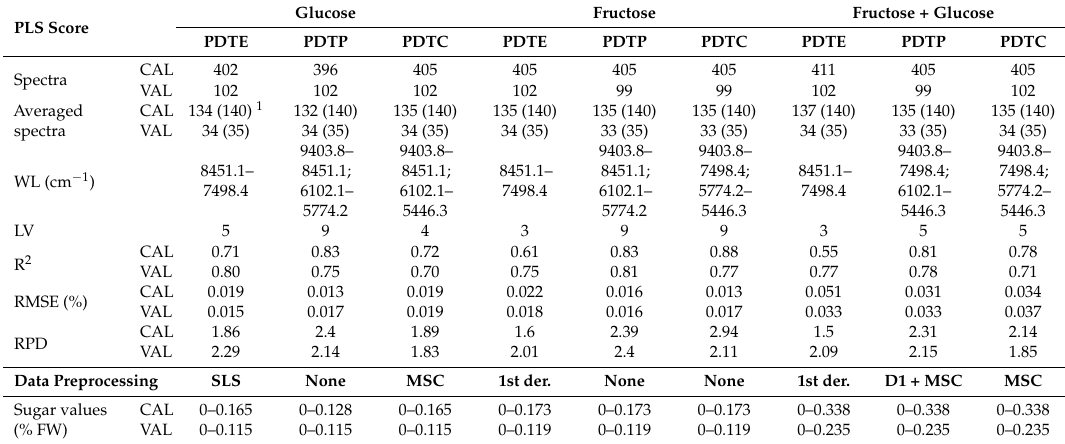
Table 4. PLS values of sugar content prediction of the potato variety Markies.